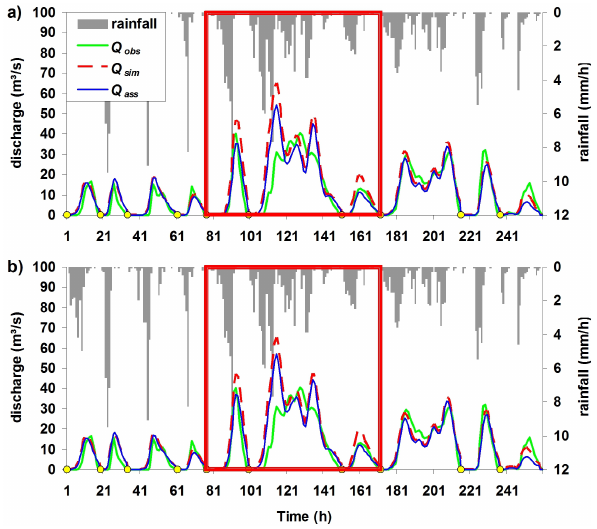
Fig. 6. – Sequence of the simulated flood events with and with- out ASCAT SWI ∗ assimilation for the CHI catchment in the period January 2007–June 2009 and considering an unbiased error on: (a) rainfall, and (b) model parameters. The simulated and assimilated discharge represents the average of 100 model runs.